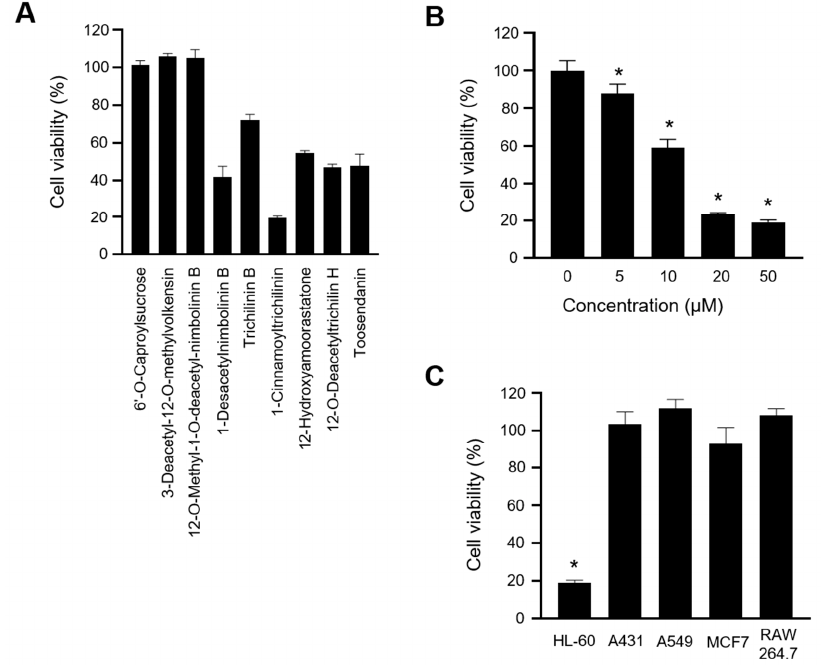
Figure 2. Growth inhibitory effects of 1-cinnamoyltrichilinin (CT) on HL-60 cells. ( A ) 3-(4,5- dimethylthiazol-2- yl)-2,5-diphenyltetrazolium bromide (MTT) colorimetric assay for natural compounds (50 µ M) extracted from M. azedarach , over 24 h, using HL-60 cells. ( B ) Cell viability of HL-60 cells incubated with various concentrations of CT for 24 h. ( C ) Cytotoxic e ff ects of CT (20 µ M) for 24 h on various human cancer cells and a normal cell line (RAW 264.7). Data represent the mean ± SEM from at least triplicate determinations. * indicates p < 0.05 calculated by one-way